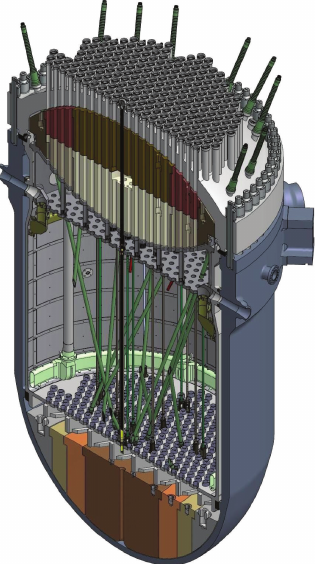
Figure 3: Reactor pressure vessel 3D model. The coolant channels are not represented in order to show the slanted control rod guide tubes. The cut was done through the axis of two of the four moderator loops outlet pipes. Cold moderator enters the vessel from the top and pours into the tank via the torus located at the bottom grid.